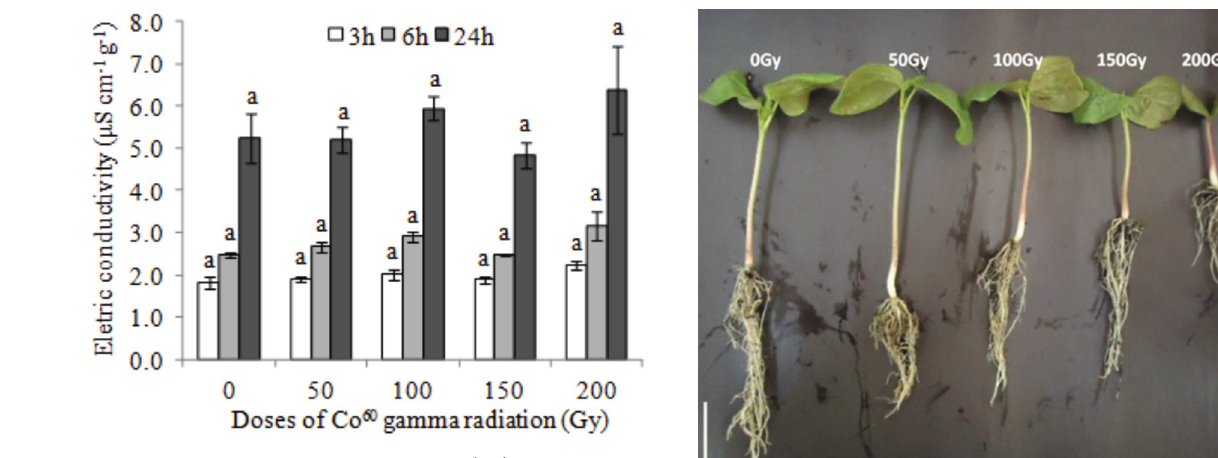
Figure 1 - Electrical conductivity (μS cm -1 g -1 ) in castor bean seeds (cv IAC 80) exposed to diff erent doses of Co 60 gamma radiation (Gy) after 3 (□), 6 (■) and 24 hours (■) of incubation. Means followed by diff erent letters are signifi cantly diff erent based on Tukey’s test (P<0.05). Bars represent the standard error of the mean of four replications.